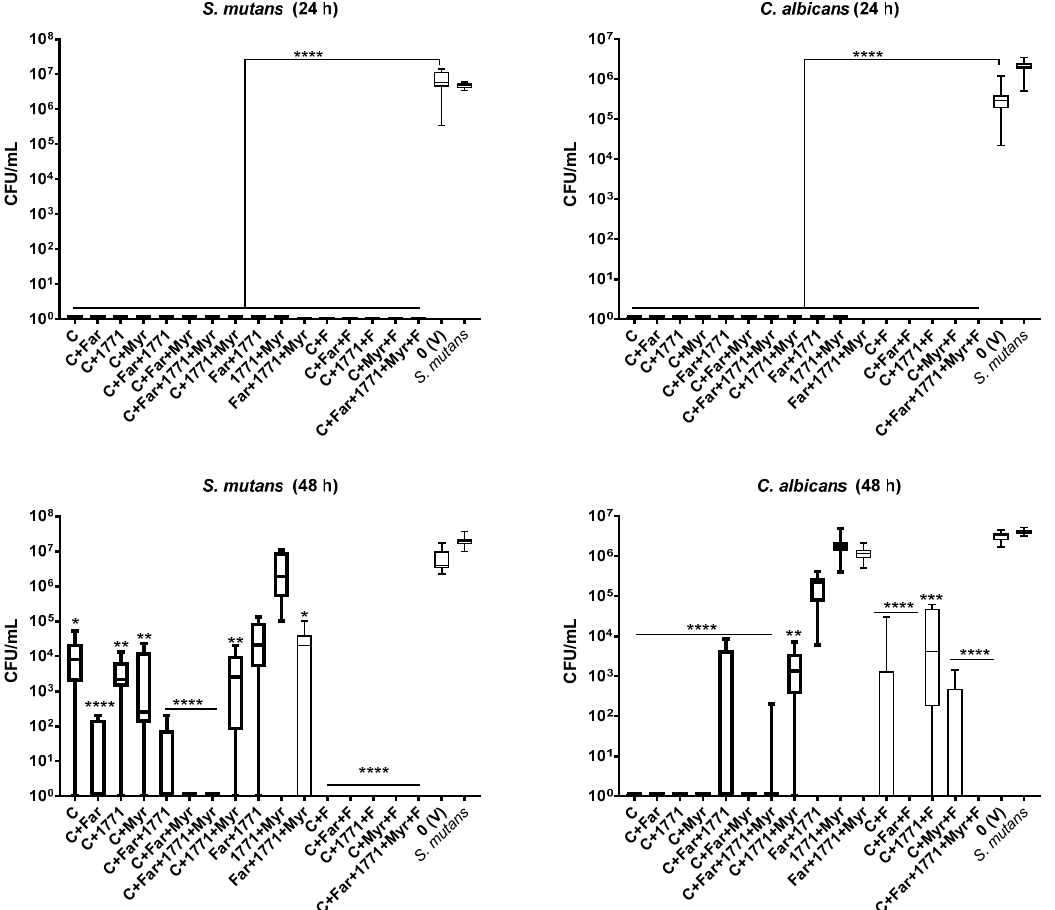
Figure 5. Antibiofilm activity of dual-species S. mutans and C. albicans biofilms with combined compounds (with and without sodium fluoride): C135 (C), tt -farnesol (Far), myricetin (Myr), 1771, and sodium fluoride (F). The top graphs presented data of 24 h biofilm (initial biofilm formation). The bottom graphs depict data of pre-formed biofilms (48 h). The data represents median and interquartile ranges ( n = 9). Statistical differences are represented with * ( p = 0.04), ** ( p ≤ 0.002), *** ( p = 0.0007), and **** ( p ≤ 0.0001) (Kruskal Wallis, followed by Dunn’s test). The tabulated results are in Table S5.